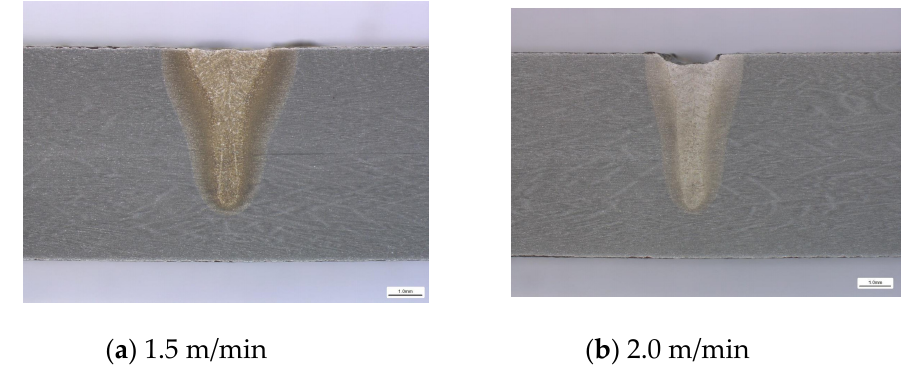
Figure 9. Cross-sectional observation results.